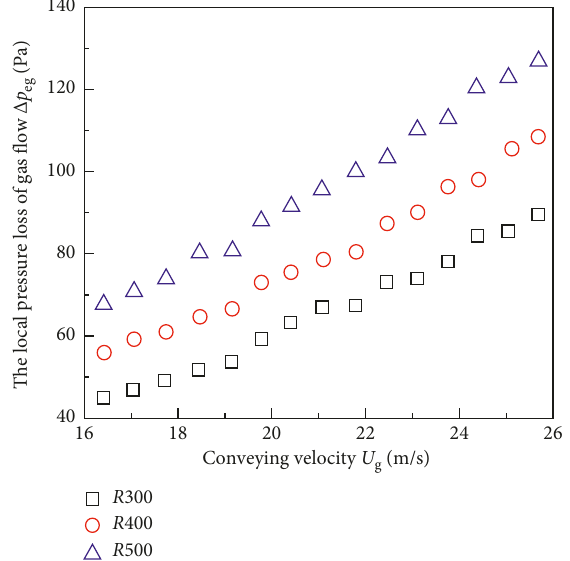
Figure 4: The local pressure loss of airflow versus conveying ve- locities and bend radii.